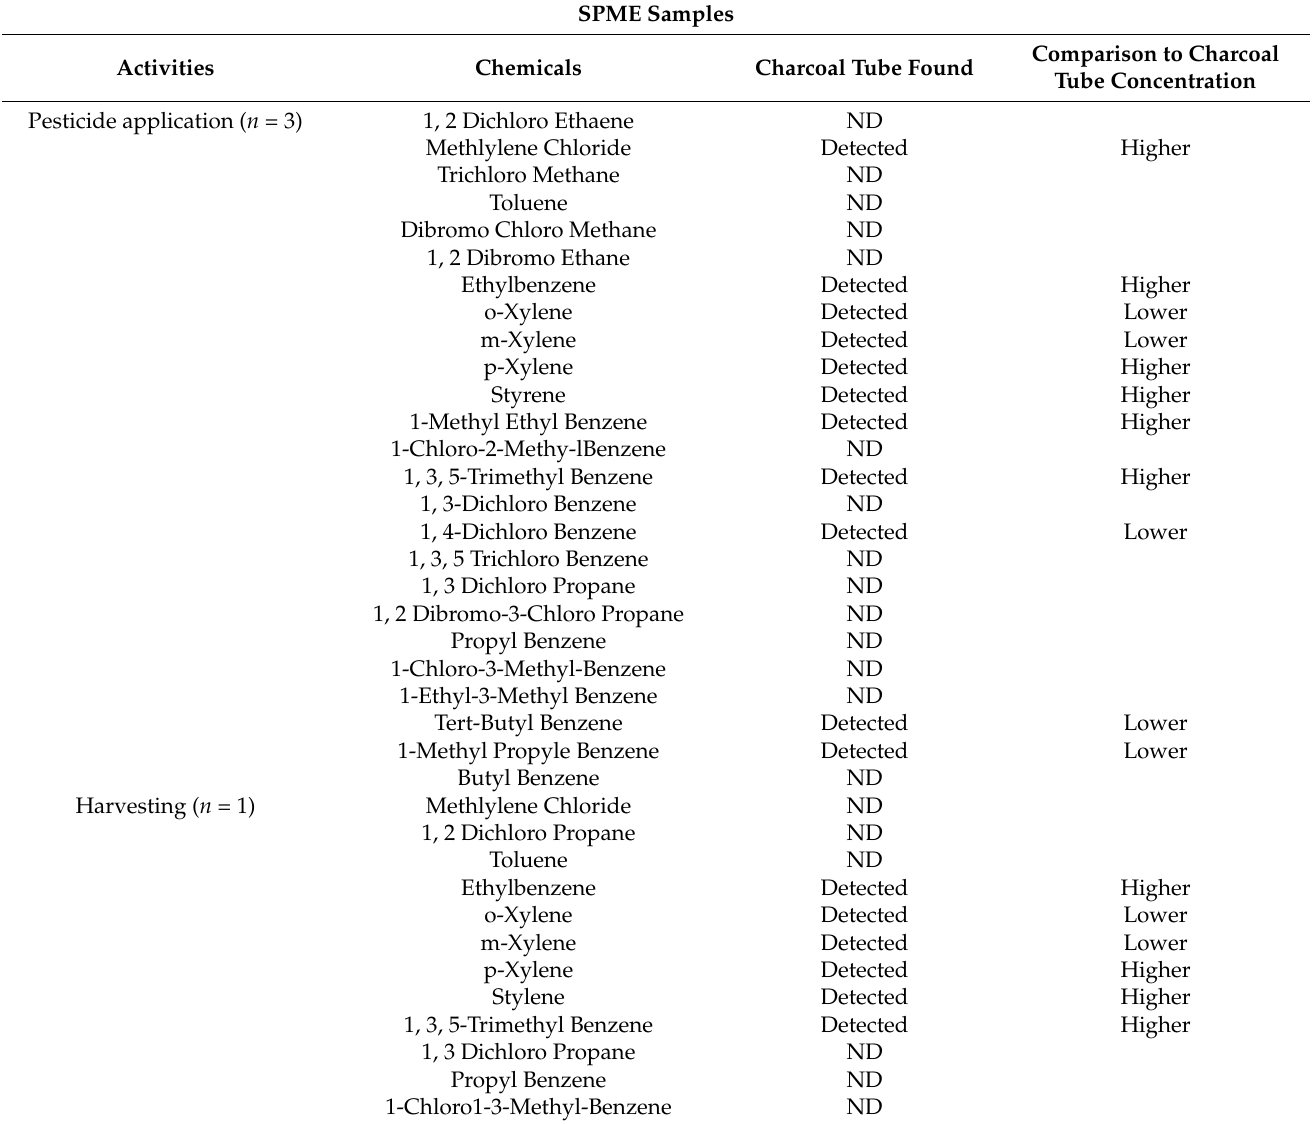
Table 4. The comparison between the compounds detected by SPME and charcoal